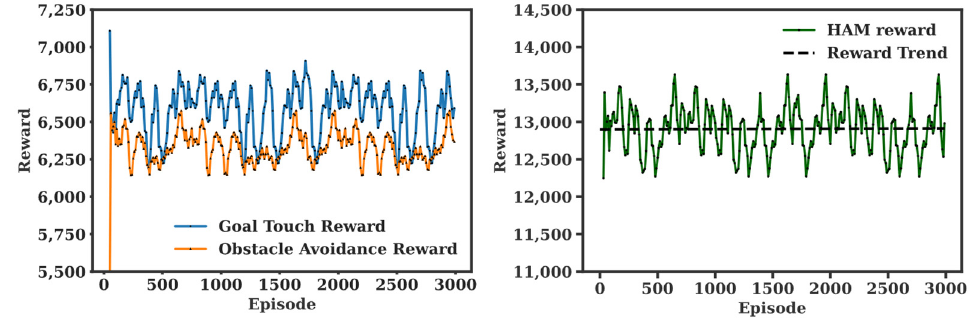
Figure 4. Path planning and obstacle avoidance by HAM.